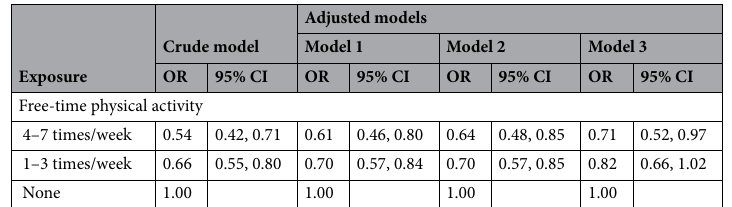
Table 2. Association* between free-time physical activity and poor sleep quality (PSQI > 5) in Brazilian university students. PSQI Pittsburgh Sleep Quality Index, OR odds ratio, CI confidence interval. *Logistic regression model for estimating the OR and 95% CI of the association between free-time physical activity (independent variable) and poor sleep quality (dependent variable). “None” was selected as a reference group. Model 1 included the adjustment variables sex and age. Model 2 added weight status, alcohol intake, tobacco smoking and fruit consumption to Model 1. Model 3 added social support and the presence of depressive symptoms to Model